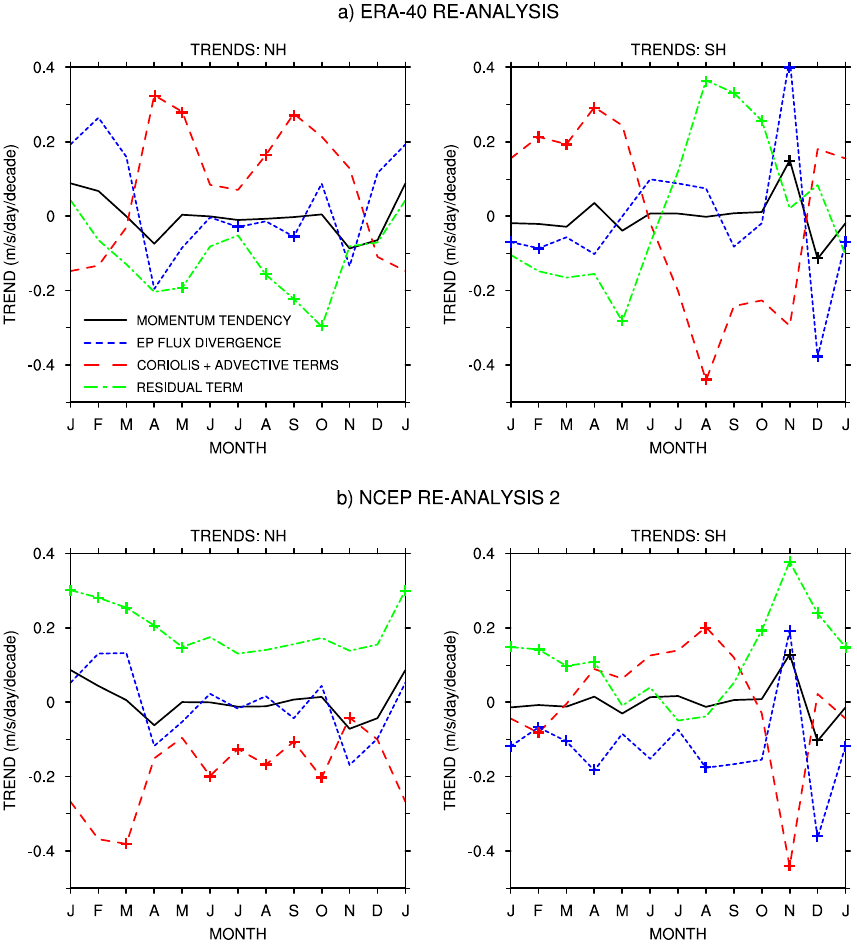
Fig. 9. Annual cycle of the trends in the momentum tendency and its forcing terms for the ERA-40 and R-2 reanalyses. The trends are calculated after the momentum tendency and its forcing terms are averaged between 100 and 20hPa and between 50 ◦ –80 ◦ . Trends that are statistically significant at the 95% level are indicated with a